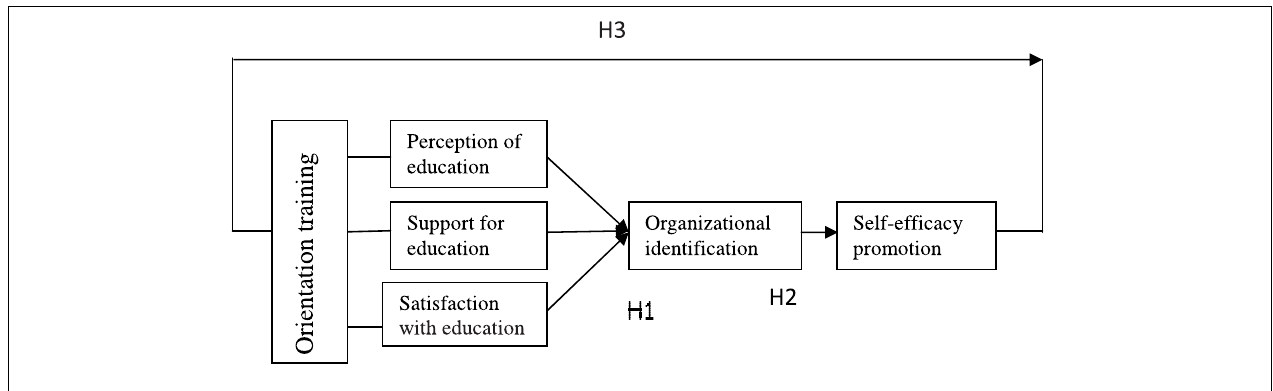
FIGURE 1 | Conceptual